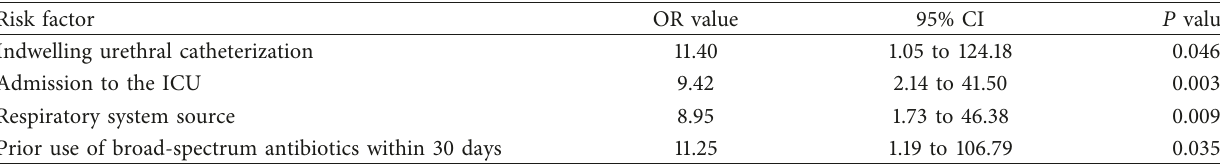
Table 2: Analysis of risk factors for CRE bloodstream infections (logistic regression analysis). Risk